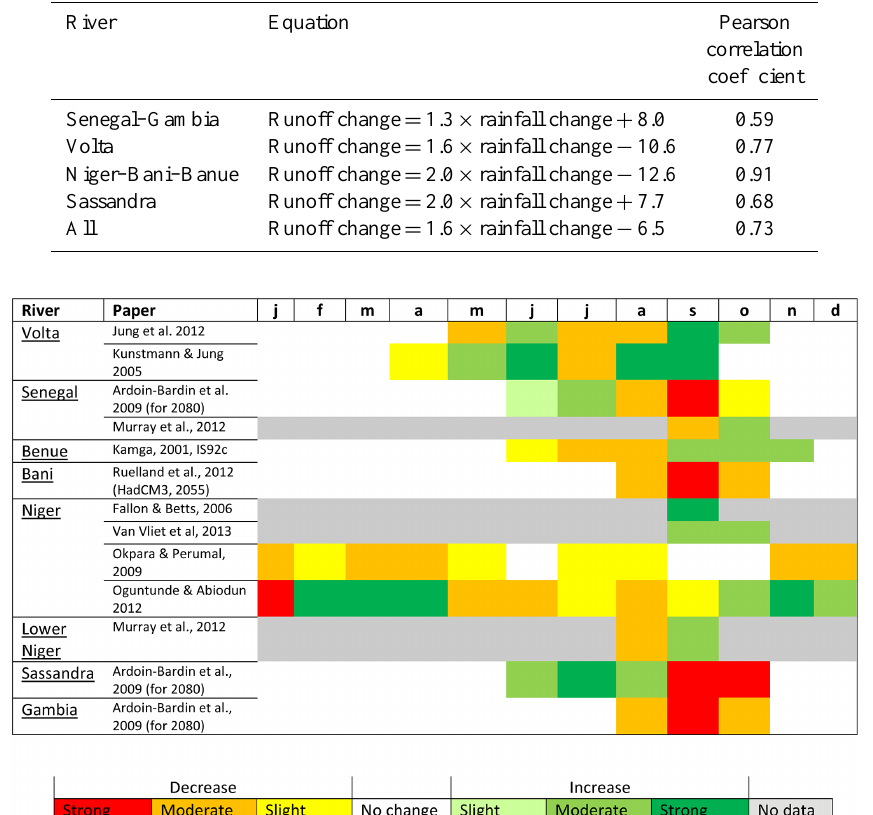
Figure 7. Qualitative assessment of monthly runoff relative change, for different studies of the database and for different rivers. The assess- ment may be an interpretation of the paper’s results (see Table 4 for more details about each paper results). In some cases we only detailed here one time horizon or one climate